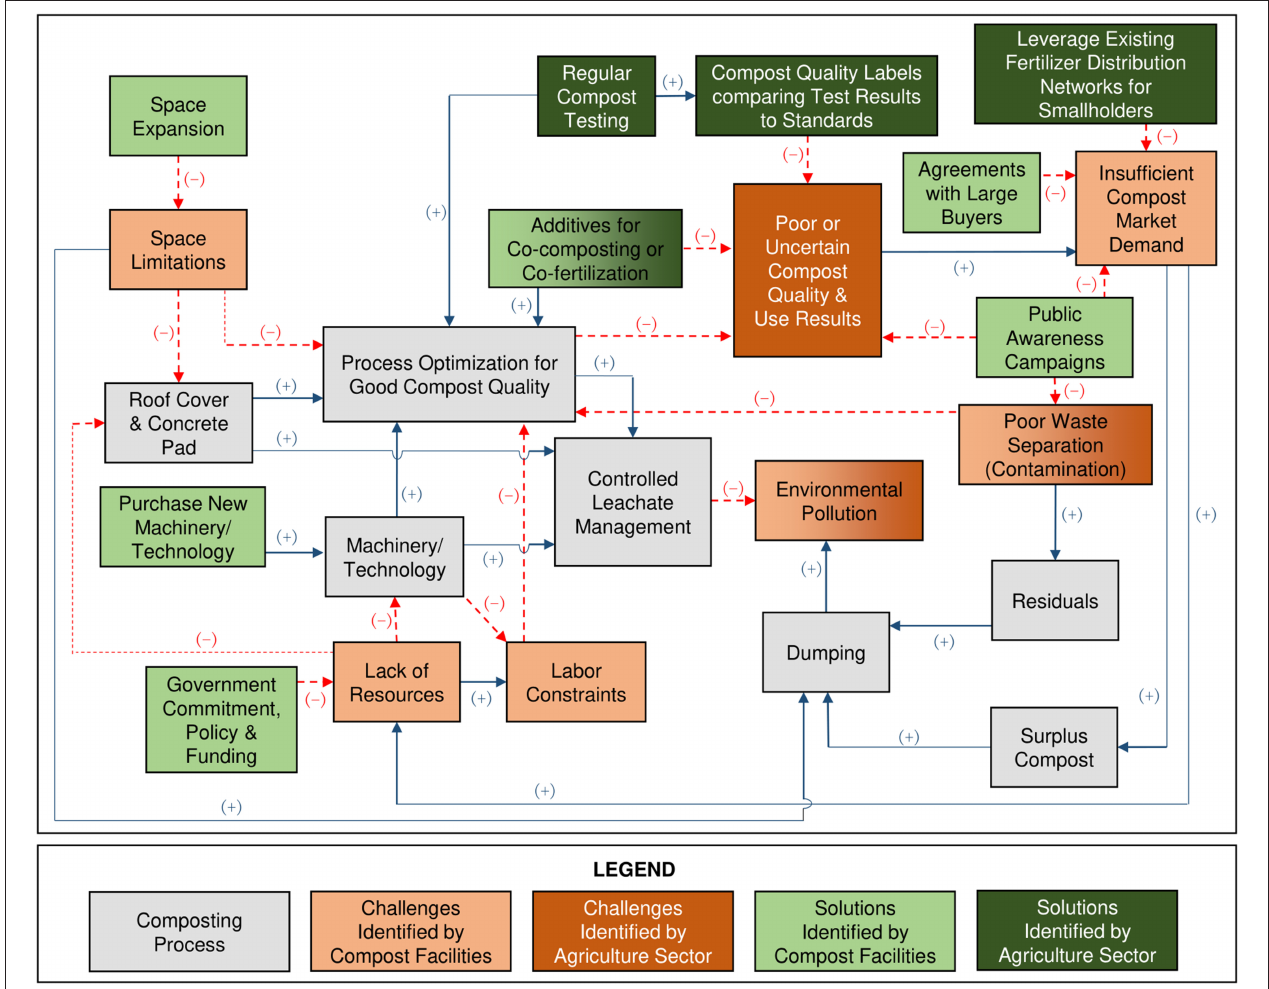
FIGURE 5 | Causal loop diagram showing the main dynamics of MSW compost systems in Sri Lanka as identified from interviews and stakeholder workshops. Color gradients indicate identification by both compost facilities and the agriculture sector. Dotted red arrows with (–) symbol indicate decrease (e.g., lack of resources can decrease roof cover and concrete pad). Solid blue arrows with ( + ) symbol indicate increase (e.g., regular compost testing can increase process optimization for good compost